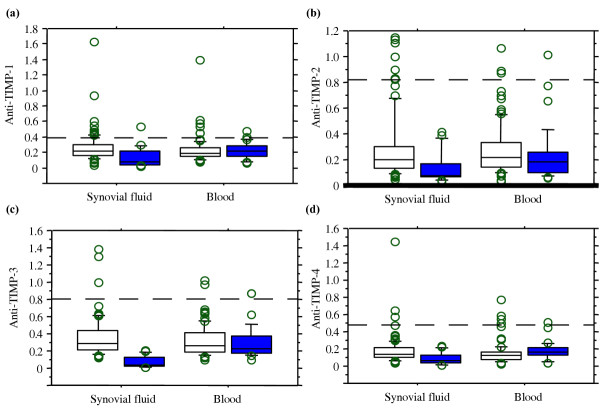
Autoreactivity against TIMPs in blood and synovial fluid of patients with RA and in controls. Autoreactivity was measured as absorbance at 450 nm. White boxes, patients with RA, n = 89; coloured boxes, controls (blood n = 62, synovial fluid n = 21). The box plots represent the means and interquartile ranges in each group. The dashed line indicates the cut-off level for each type of TIMP equal to the mean +2 standard deviations of the controls. TIMP, tissue inhibitor of metalloproteinases.